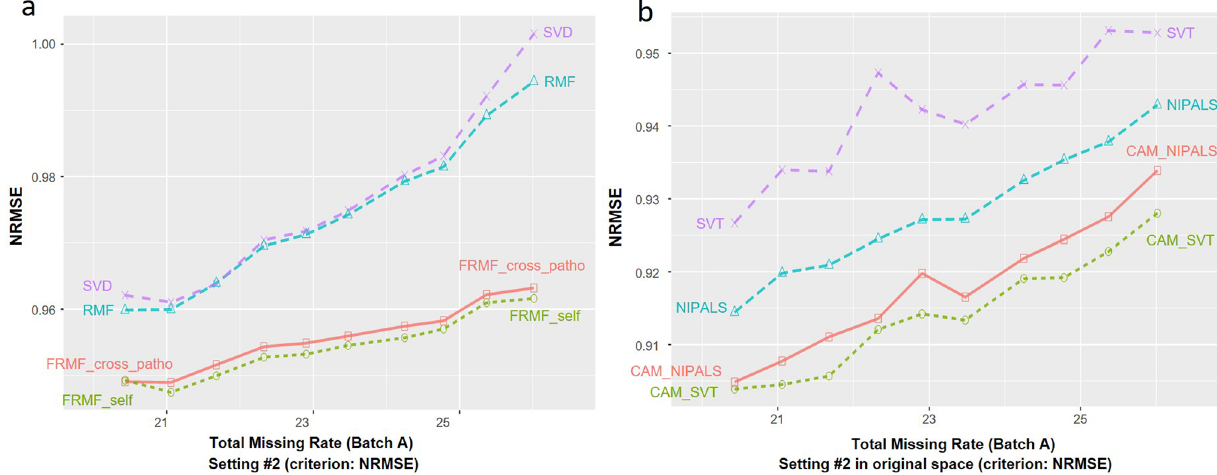
Figure 4. ( a ) Imputation performance of the FRMF variants on the simulation data of setting #2, with varying masked rates. ( b ) Imputation performance of CAM variants on the simulation data of setting #2, with varying masked rates, in comparison to that of SVT and NIPALS. The imputation accuracy is evaluated in the original intensity space (before